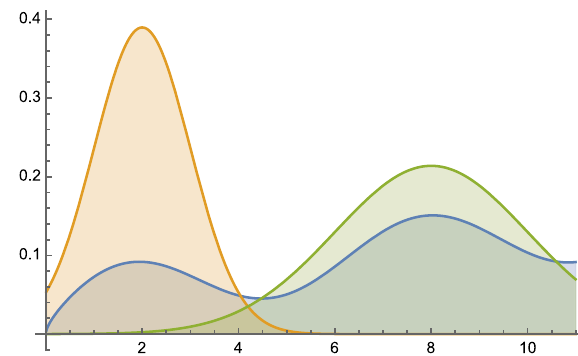
Fig. 2 Example 1: f ( x )/µ (in blue) superimposed on the two pdfs used for MIS integration